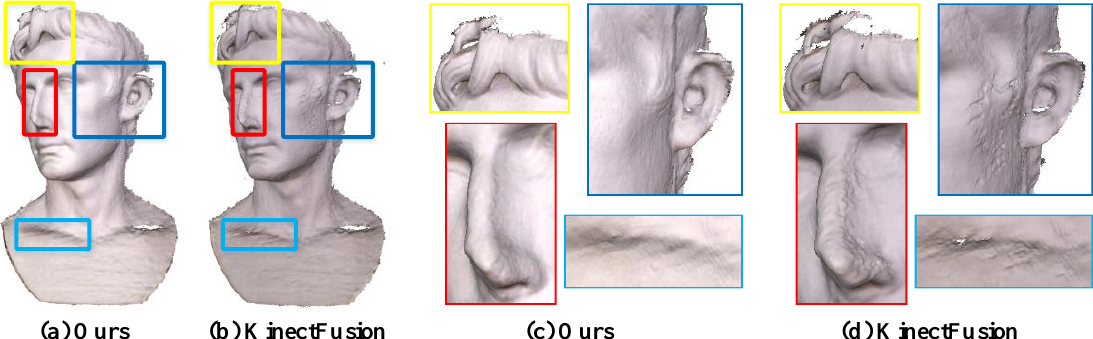
Figure 8. The reconstruction results of the August dataset. Comparing with the classical weighted average fusion method [6] ( b , d ), our results ( a , c ) can deal with the details of geometry.